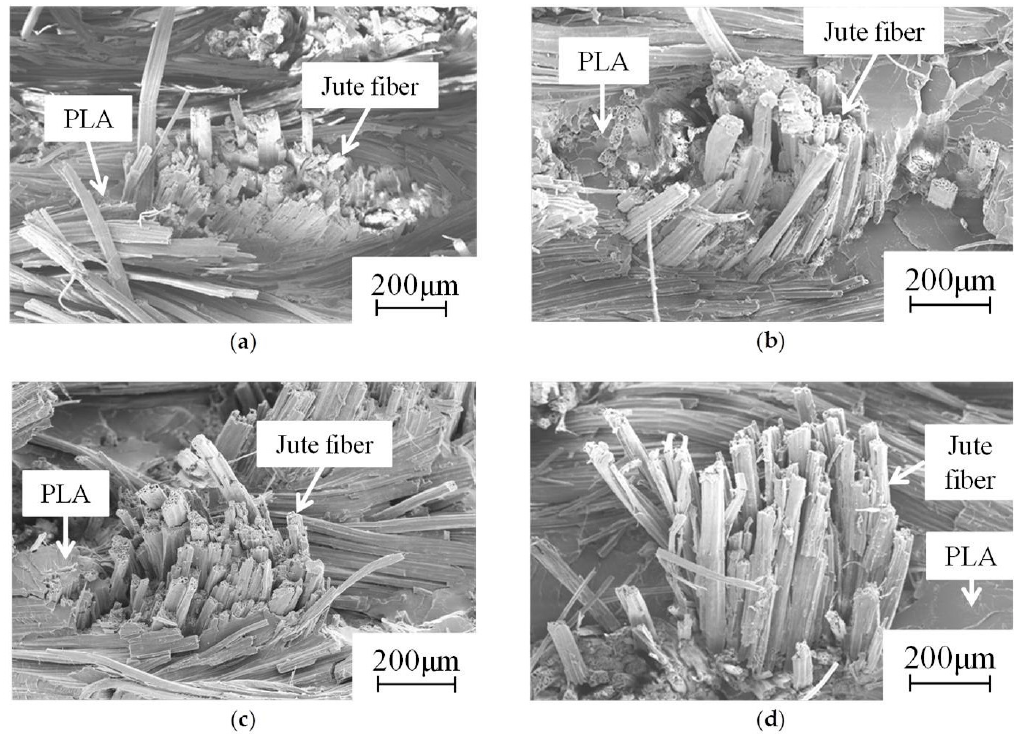
Figure 9. Fiber pull out in fracture surface of green composite after thermal cycling (35–55 °C): ( a ) 1 cycle; ( b ) 10 cycles; ( c ) 10 2 cycles; ( d ) 10 3 cycles.